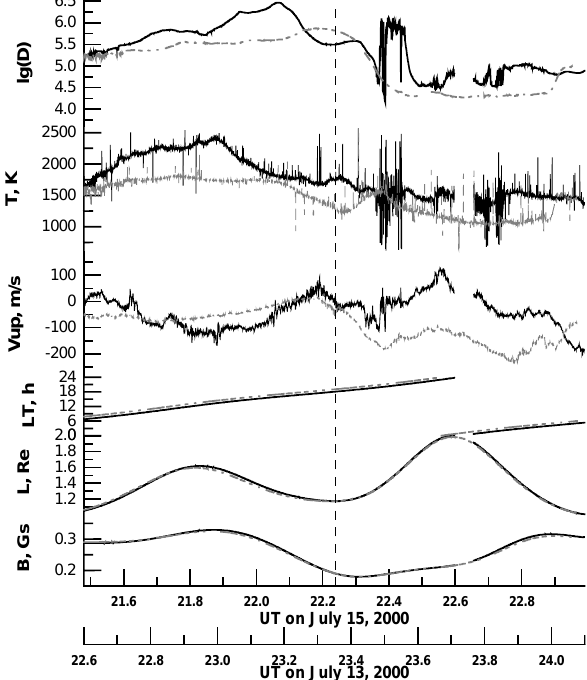
Fig. 2. Comparison of prestorm ionospheric conditions on 15 July (black solid line) with quiet day on 13 July (gray dashed lines) for overlapping orbits of the ROCSAT-1 satellite. Passing the iono- spheric regions with practically the same local time LT, magnetic field B and drift shells L , the satellite observes very close time pro- files of the ion density D , temperature T and upward velocity V up . Vertical dashed lines depict the geomagnetic equator.